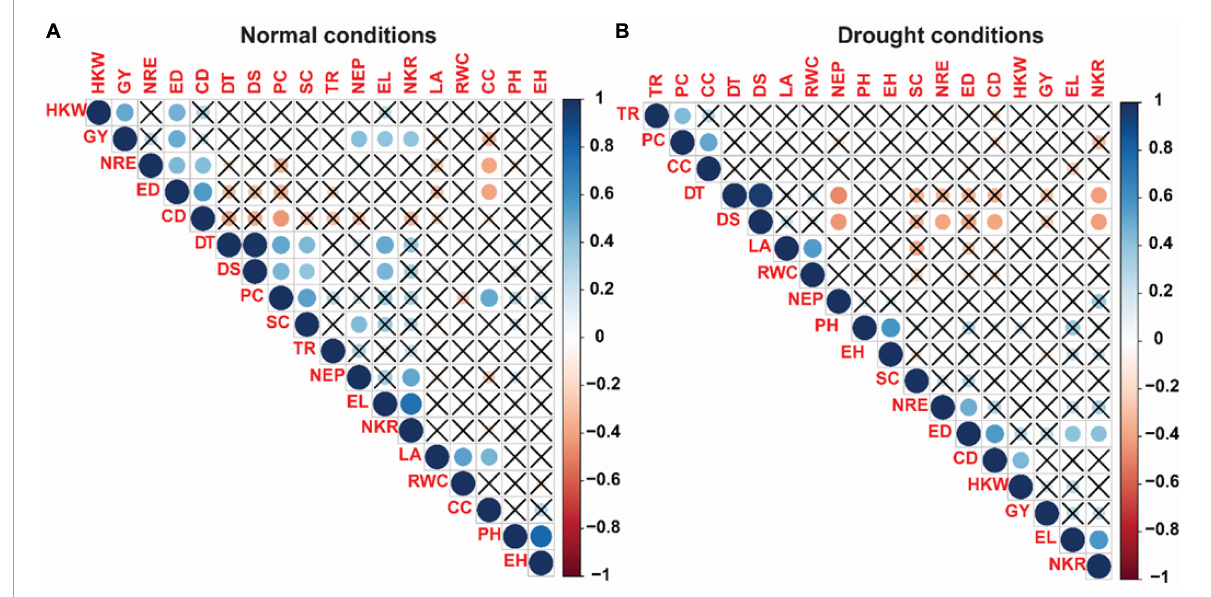
FIGURE5 Correlation matrix of the 18 measured traits of 45 maize inbred lines evaluated under normal (A) and drought stress (B) conditions. The increasing color intensities illustrate a higher correlation coefficient. DT, days to 50% tasseling; DS, days to 50% silking; PH, plant height (cm); EH, ear height (cm); NEP, no. of ears/plant; EL, ear length (cm); ED, ear diameter (cm); CD, cob diameter (cm); NRE, no. of row/ear; HKW, 100-kernel weight (g); NKR, number of kernel/row; GY, grain yield (ardbe/fed); LA, leaf area (cm 2 ); RWC, relative water content (%); PC, proline content (mg g - 1 ); CC, chlorophyll content (SPAD); TR, transpiration rate (mmol m - 2 s - 1 ); SC, stomatal conductance (mol m - 2 s - 1